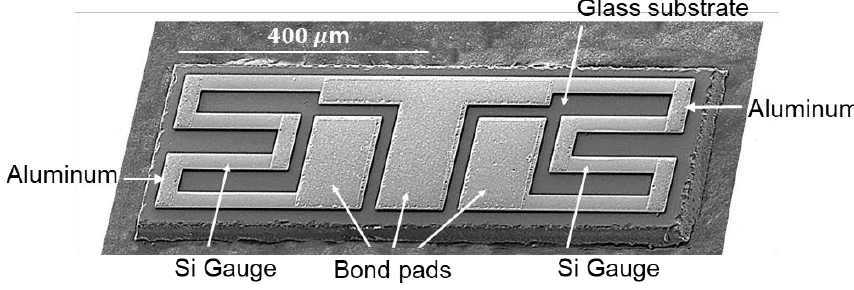
Figure 4. SEM micrograph of diced half-bridge chip with two Si strain gauge elements and three bond pads.